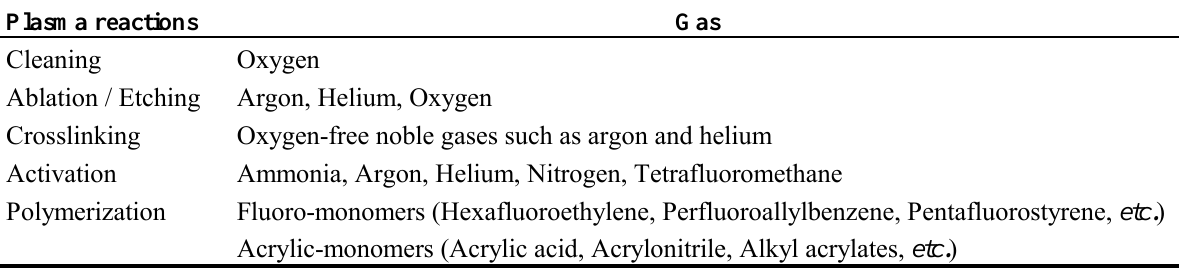
Table 2. Various gases used for plasma